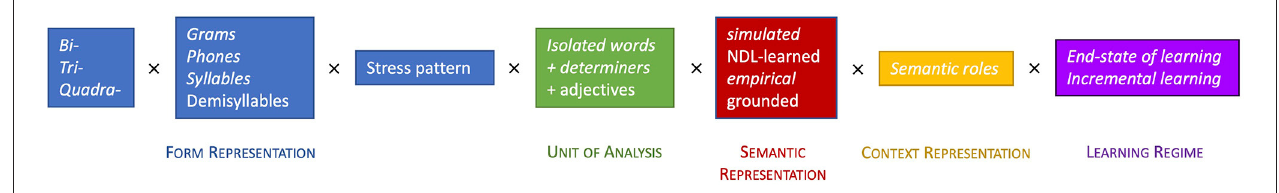
FIGURE 1 | Options when modeling a language’s morphology with LDL. Examples with options in italics are discussed in the present study.